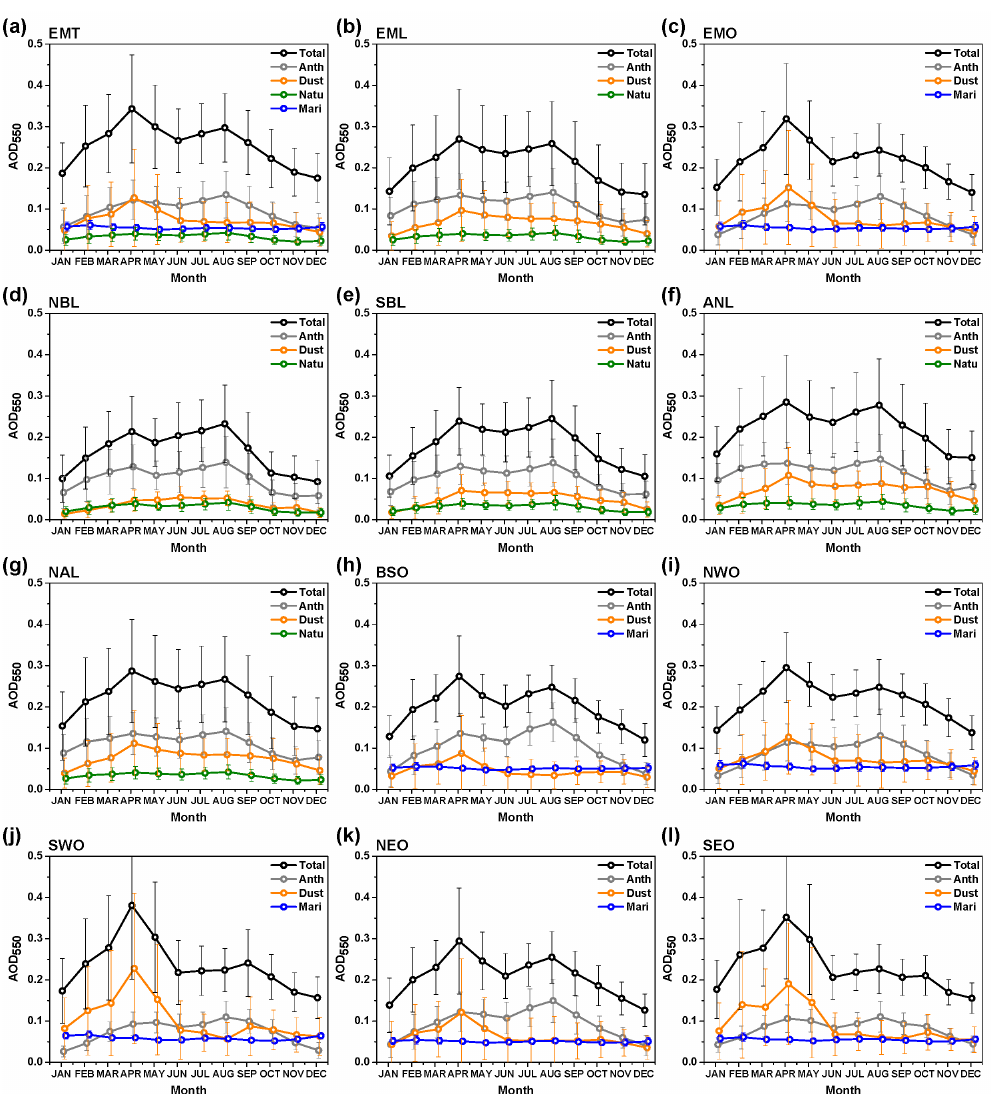
Figure 12. Seasonal variability of anthropogenic aerosols ( τ a ) , dust ( τ d ) , fine-mode natural aerosols ( τ n ) and marine aerosols ( τ m ) over the Eastern Mediterranean (EMT), over the land-covered part (EML), over the oceanic part (EMO) and over the nine subregions of the Eastern Mediterranean appearing in Fig. 1 based on MODIS Terra observations. The error bars represent the ± 1 σ values calculated from monthly gridded